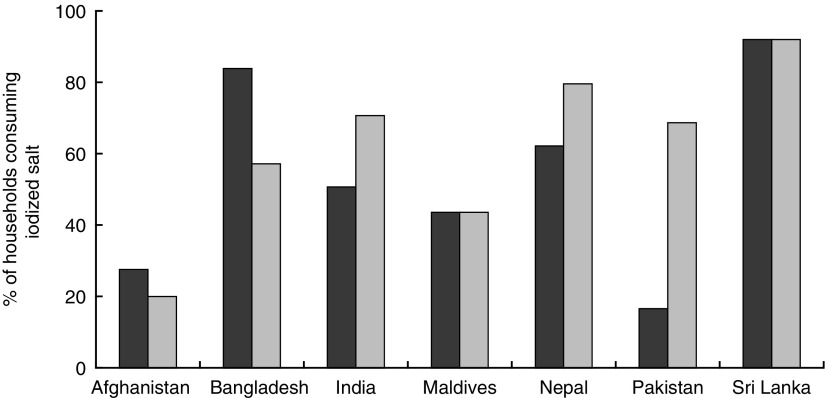
Percentage of households in South Asia consuming iodized salt in 2012
() and 2015 (),
by country. (Data from Andersson et al.(

4

) and the Iodine Global Network’s global iodine scorecard 2014–2015(

66

))